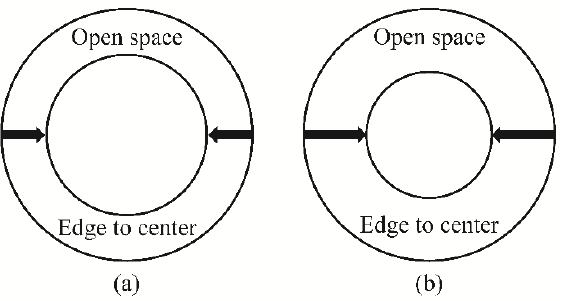
Figure 15. Type of edge open domes (Kim et al. 2019 [19]): ( a ) open ratio = 30% and ( b ) open ratio = 50%.